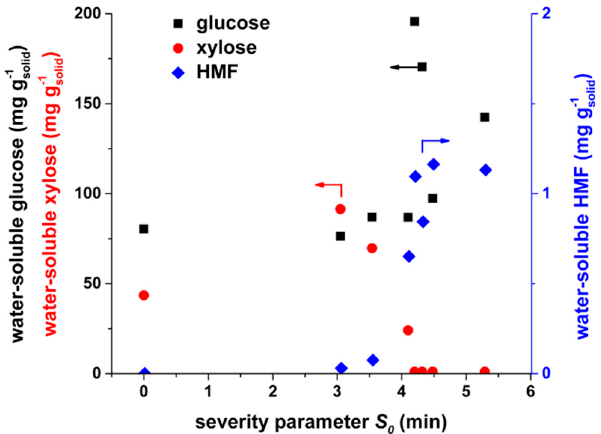
Figure 3. Water-soluble components (glucose, xylose, and hydroxymethylfurfural (HMF)) of untreated rice straw and pretreated residue depending on the severity parameter S 0 of the steam explosion. Extraction in boiling water for 3 h.